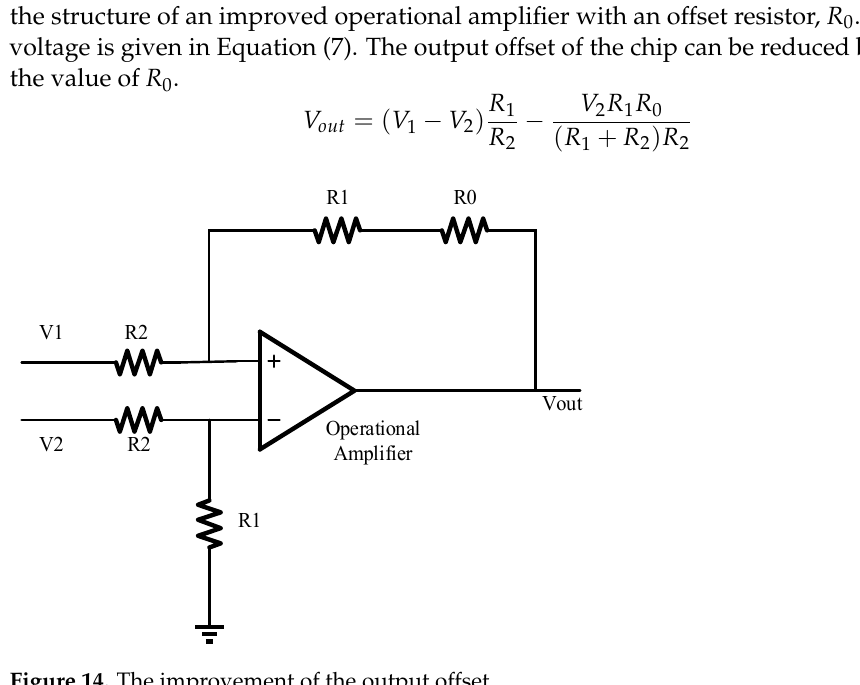
Figure 13. The PSR simulation diagram of the reference current circuit.